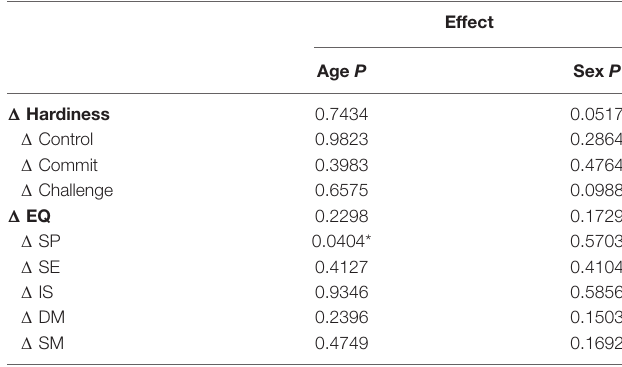
TABLE 4 | Effect of age and sex on difference ( (cid:49) ) Hardiness and EQ scores and sub